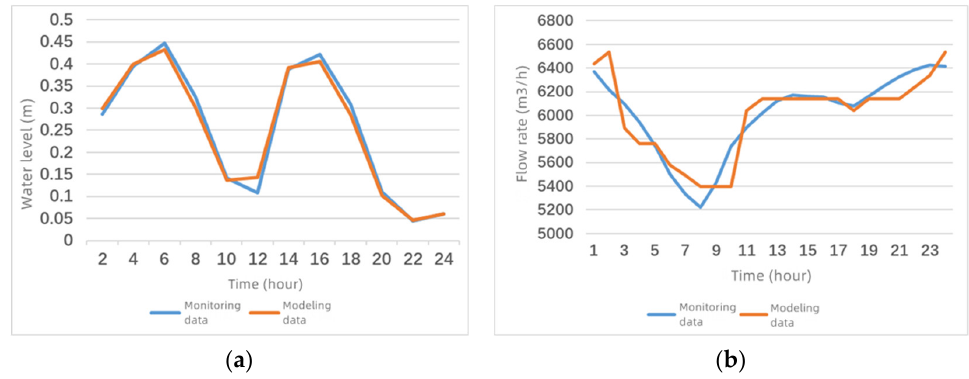
Figure 9. Calibration results. ( a ) Water level at the outlet of the area. ( b ) Inflow of the sewage treatment plant.